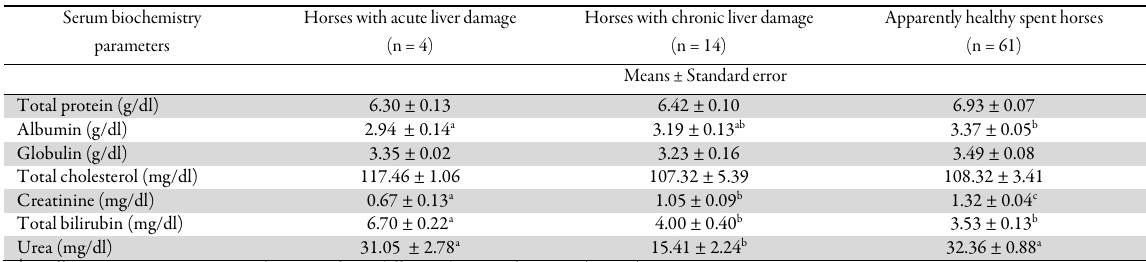
Table 2. Levels of some biochemical parameters of spent horses with liver damage compared to apparently healthy spent horses Serum biochemistry Horses with acute liver parameters